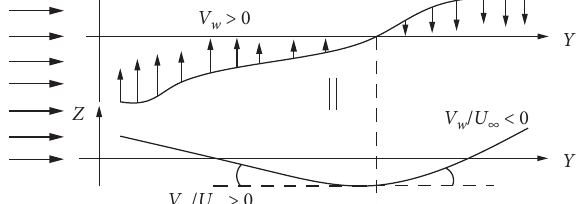
Figure 3: Equivalent diagram of the additional attack angle of the